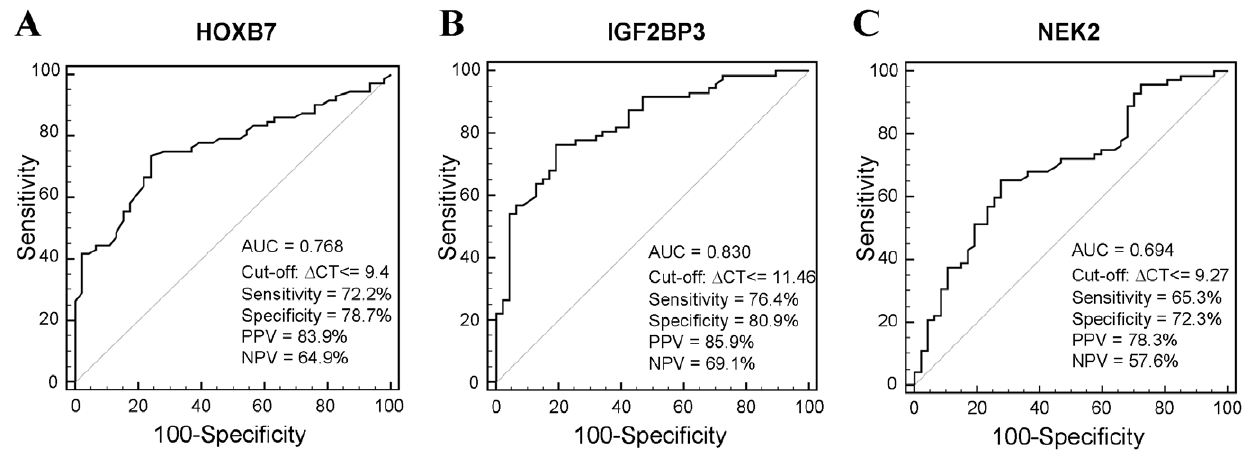
Figure 3. ROC analysis for HOXB7 (figure A), IGF2BP3 (figure B) and NEK2 (figure C) as diagnostic markers for biliary malignancy in patients with biliary strictures. Graphs show sensitivity plotted versus 100% - specificity.